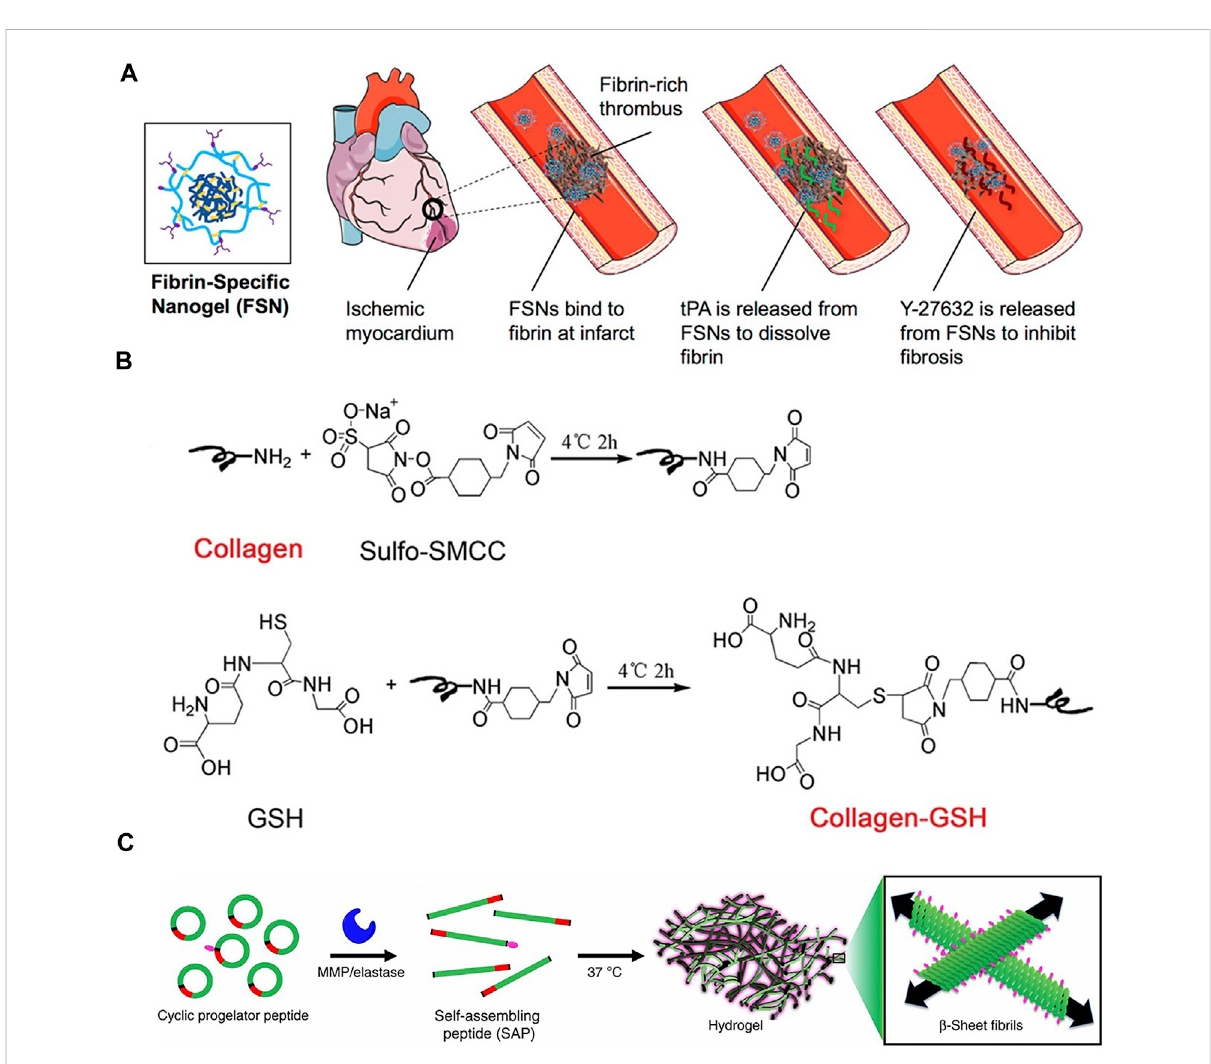
FIGURE 5 (A) Fibronectin-speci fi cpoly(N-isopropylacrylamide)nanogels(FSN)(Mihalkoetal.,2018) (B) AschematicofGSHconjugationoncollagenusing Sulfo-SMCC.(C. Fan et al., 2019) (C) A cyclic pre-gelatin peptide containing a gelation sequence (green), a matrix metalloproteinase (MMP)/elastase cleavage recognition sequence (red) and a disul fi de bond (black) that resists assembly due to conformational restrictions(Carlini et al.,